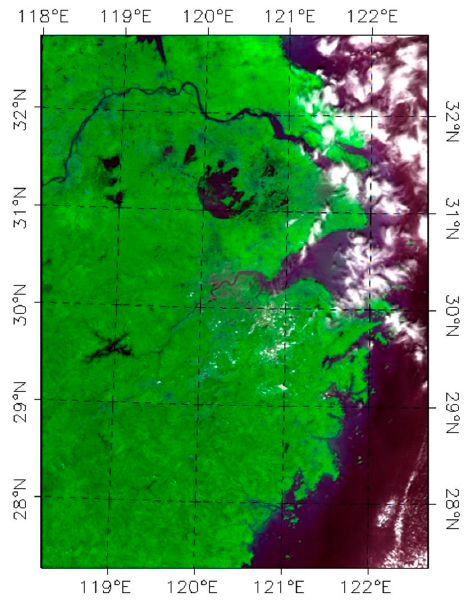
Figure 2. MODIS1B image (bands 3, 2 and 1) in 22 September 2007. Atmosphere 2017 , 8 , 139